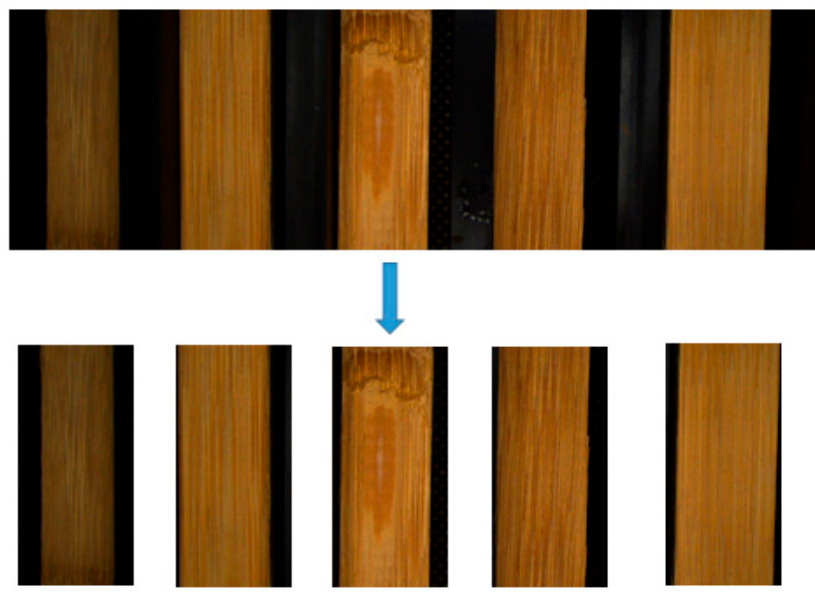
Figure 4. Camera and light system.